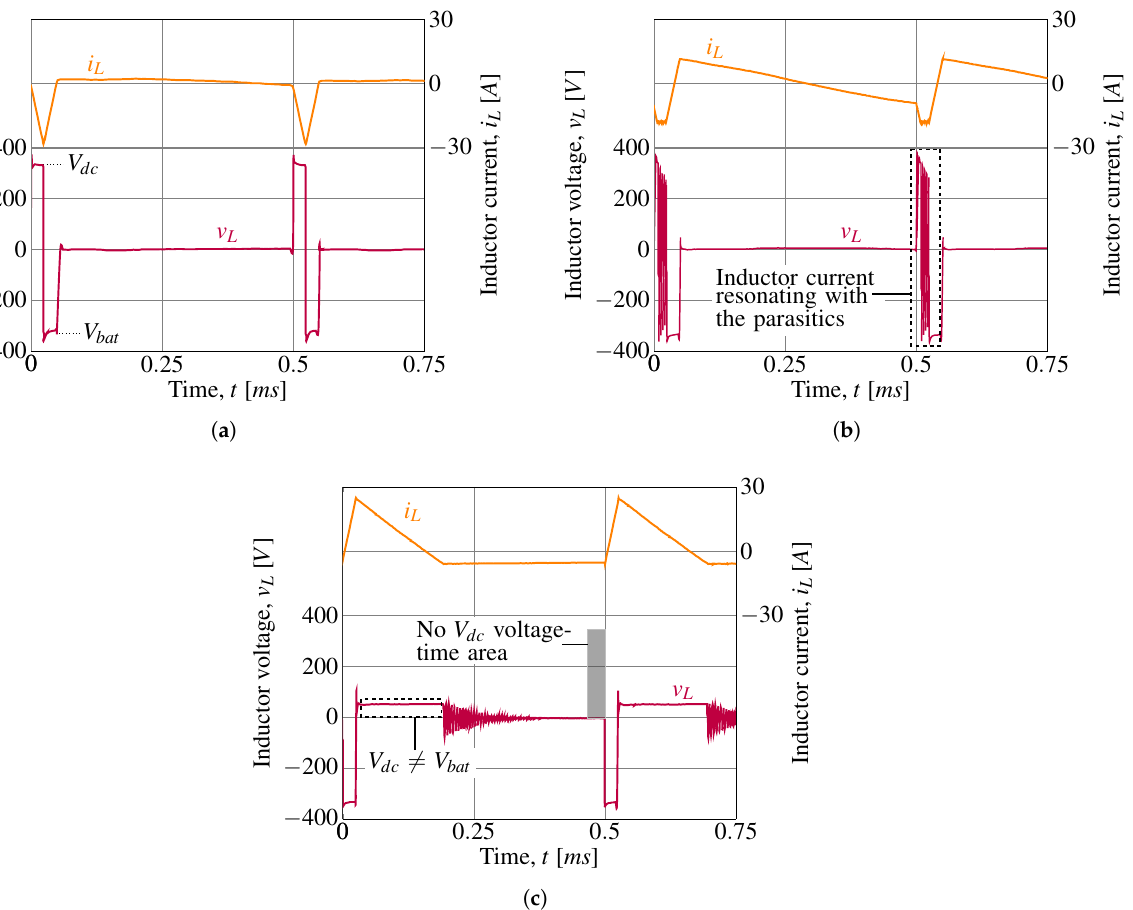
Figure 18. Inductor characteristics in CCM and DCM for different output currents: ( a ) inductor characteristics for an output current of 34 A in CCM; ( b ) inductor characteristics for an output current of 16 A in CCM; ( c ) inductor characteristics for an output current of 5 A in